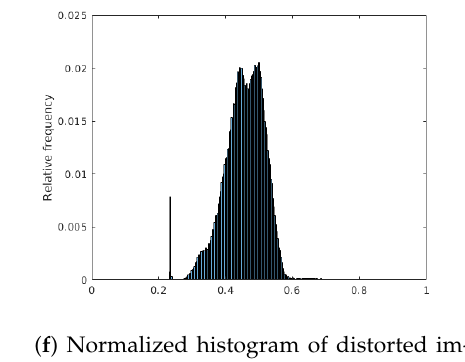
( e ) Normalized histogram of reference im- ( f ) Normalized histogram of distorted im- age’s L 55 feature map. age’s L 55 feature map. Figure 3. Illustration of Bilaplacian features. The first row contains a reference-distorted image pair. The second row consists of the Bilaplacian feature maps obtained by the L 55 filter. The third row contains the normalized histograms of the Bilaplacian feature